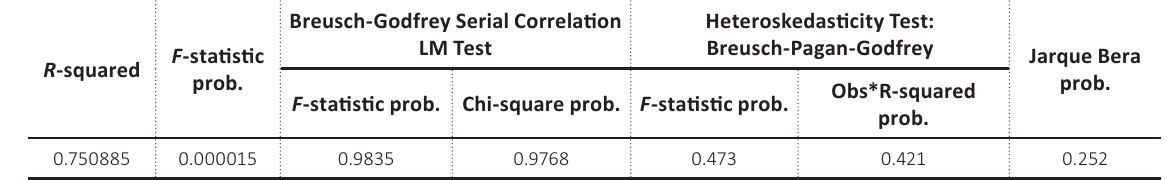
Table 4. Model quality